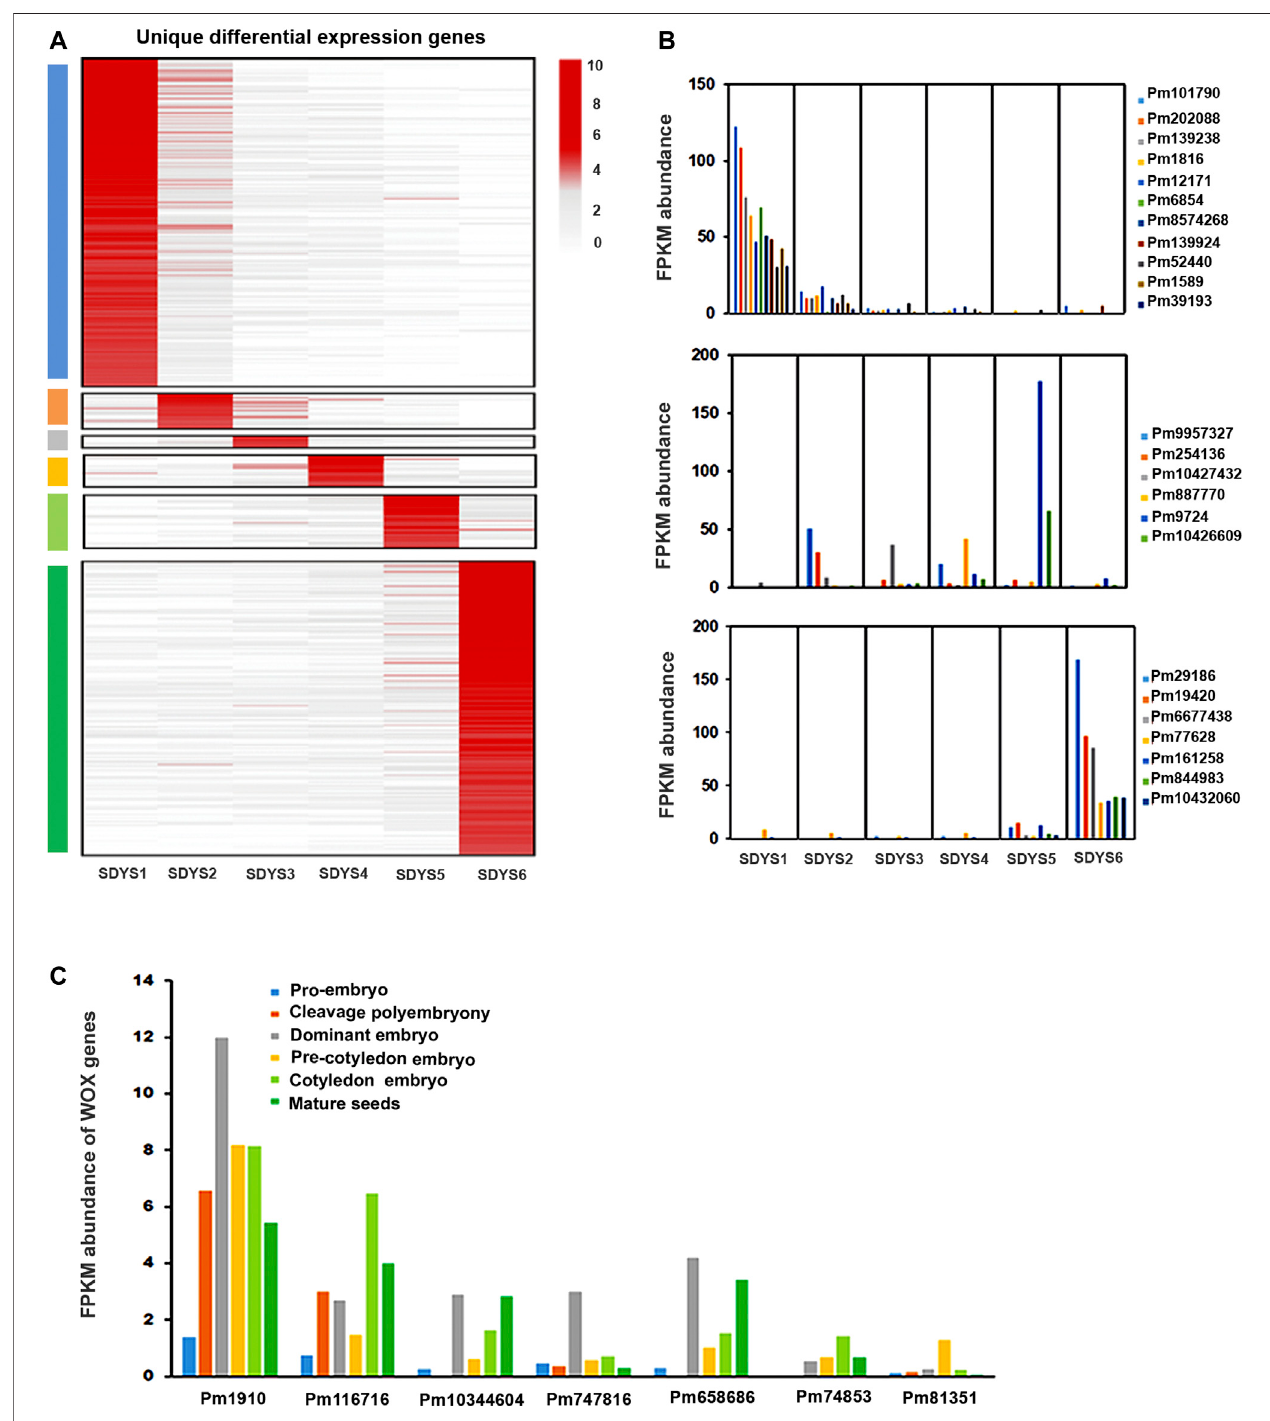
FIGURE 8 | Functions of embryonic development-speci fi c differentially expressed genes. (A) Hierarchical clustering of fold changes in transcript abundance for all speci fi c DEGs in each embryonic developmental stage. (B , C) Expression of TFs and WOX genes in different embryonic development stages.